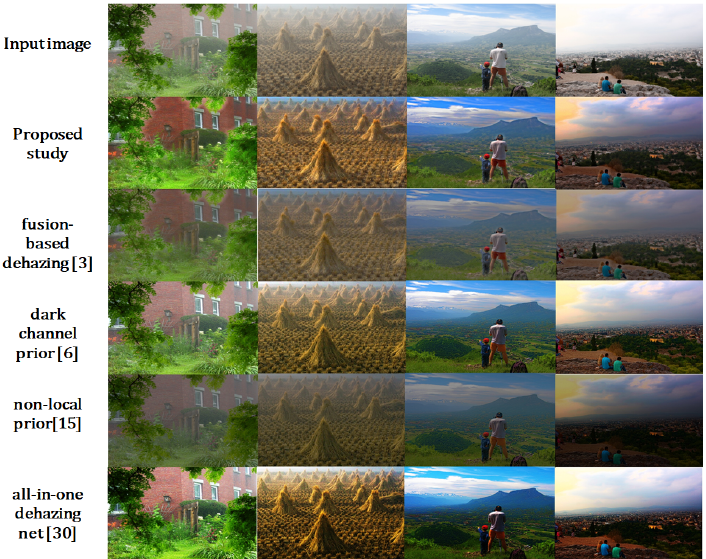
Figure 6. Visual comparison between proposed study and the selected studies for more hazy images. From top to below, input image, proposed study, Reprinted from